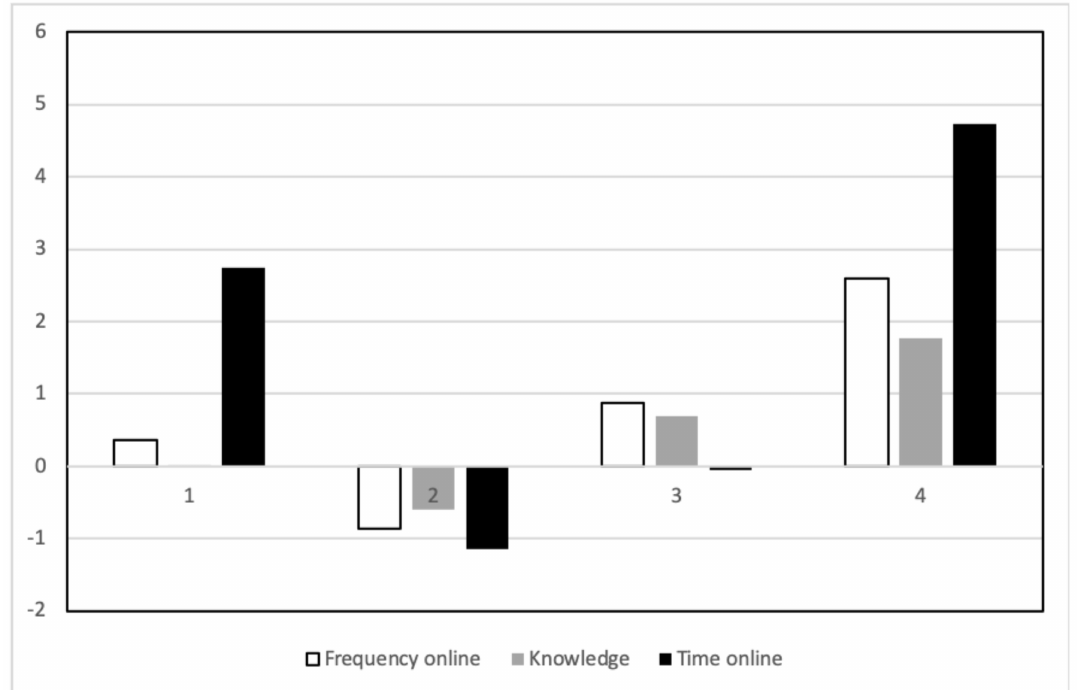
Figure 2. Model-estimated means (expressed in z-scores) for the four-class solution. On the y-axis, the z-scores of the Internet activities variables are given, and on the x-axis, the four profile groups are presented. 1—low knowledge and high time online class, 2—low knowledge and low Internet use (time online and frequency) class, 3—average knowledge and average Internet use (time online and frequency) class, and 4—high knowledge and high Internet use (time online and frequency)